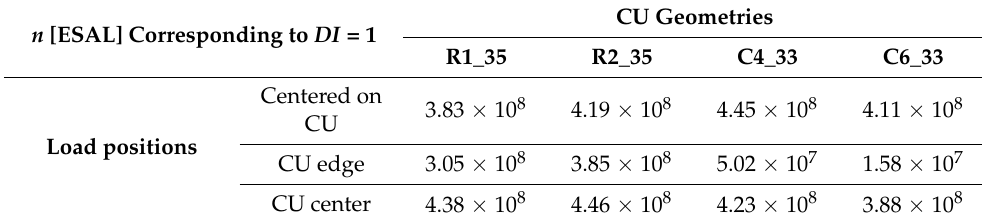
Table 6. Number of traffic repetitions n [ESAL] corresponding to DI =